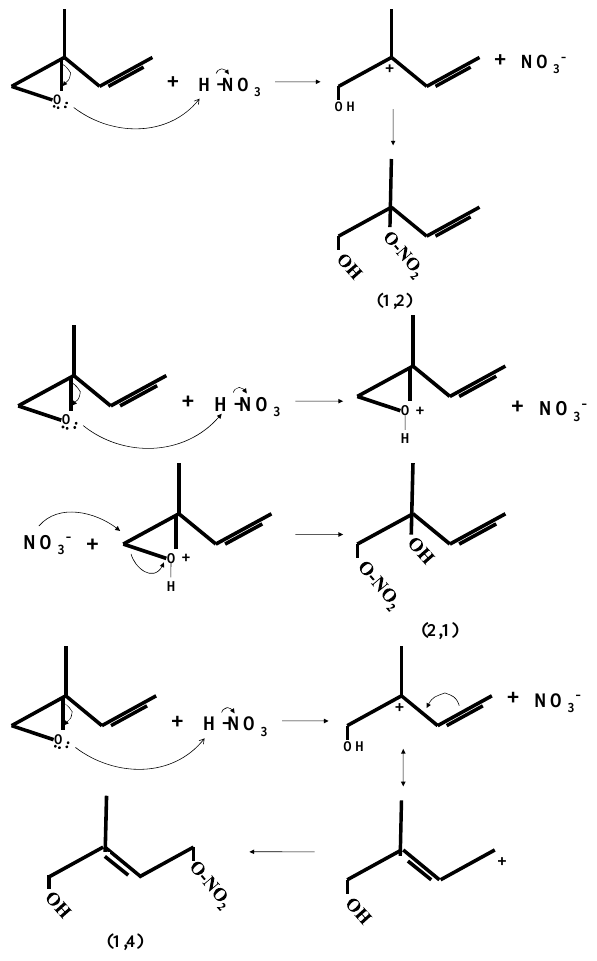
Figure 2. Isoprene nitrate synthesis chemistry Fig. 2. Isoprene nitrate synthesis chemistry.